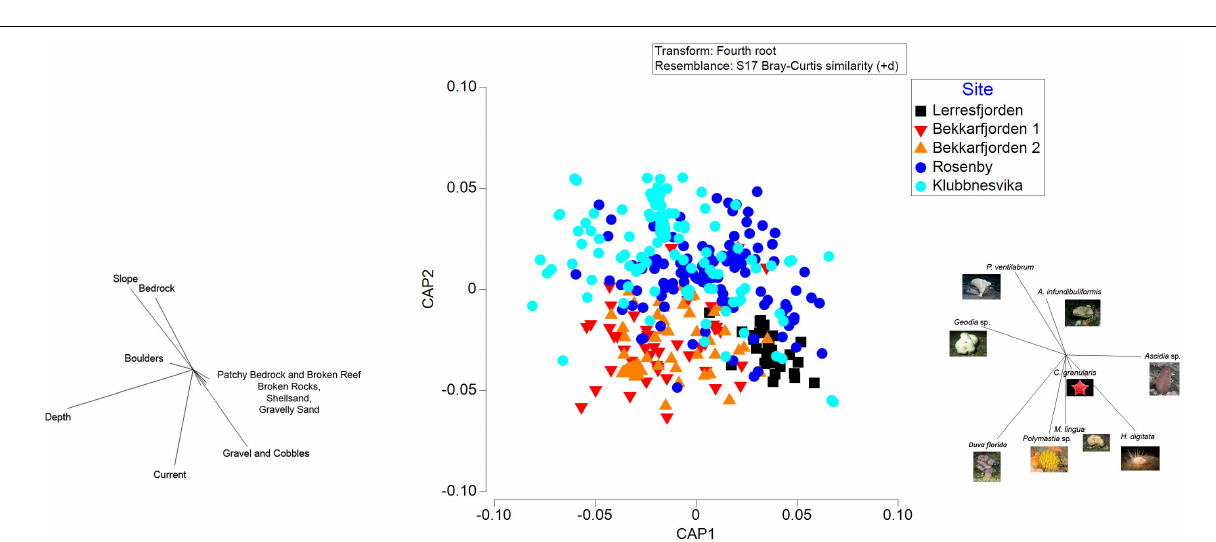
average abundance of the benthic community ( Supplementary Table 6A ). Other principal components of the epifaunal assemblages included the sponge M. lingua , cushion star C. granularis , the sponge Polymastia sp. and the sea-anemone H. digitata . Together these five taxa represented 78.3%